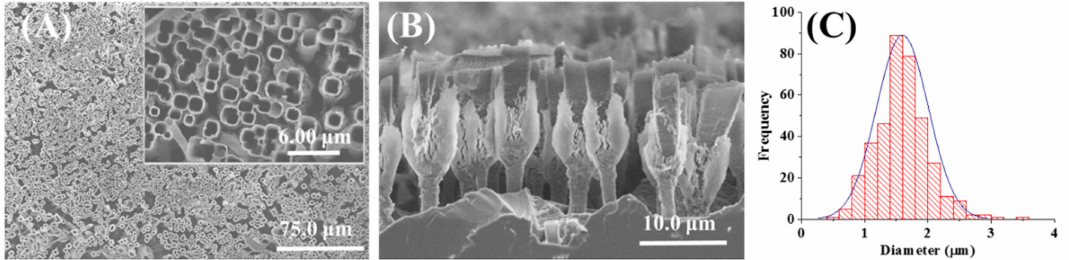
Figure 2. SEM images of Si NTs: ( A ) top view, ( B ) lateral view, ( C ) size